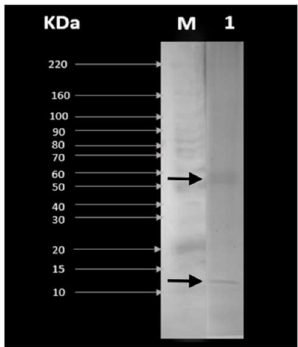
Figure 1. SDS-PAGE patterns of (1) novel protein concentrate NPC of rice ( Oryza sativa ). M is the molecular weight marker (control). First arrow (above to low) identifies glutelin fraction (57 kDa) and second arrow the prolamin fraction (12 kDa).